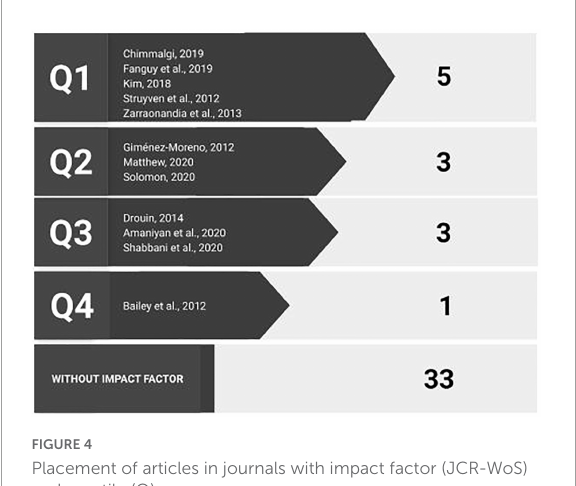
FIGURE4 Placement of articles in journals with impact factor (JCR-WoS) and quartile (Q).